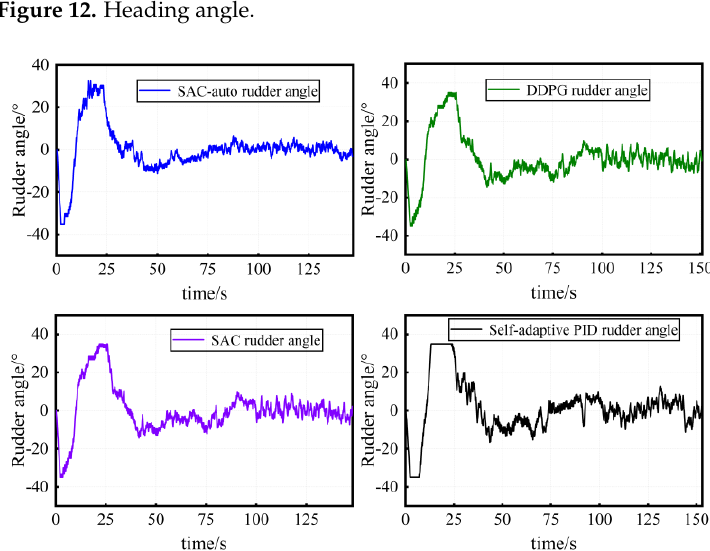
Figure 12. Heading angle.